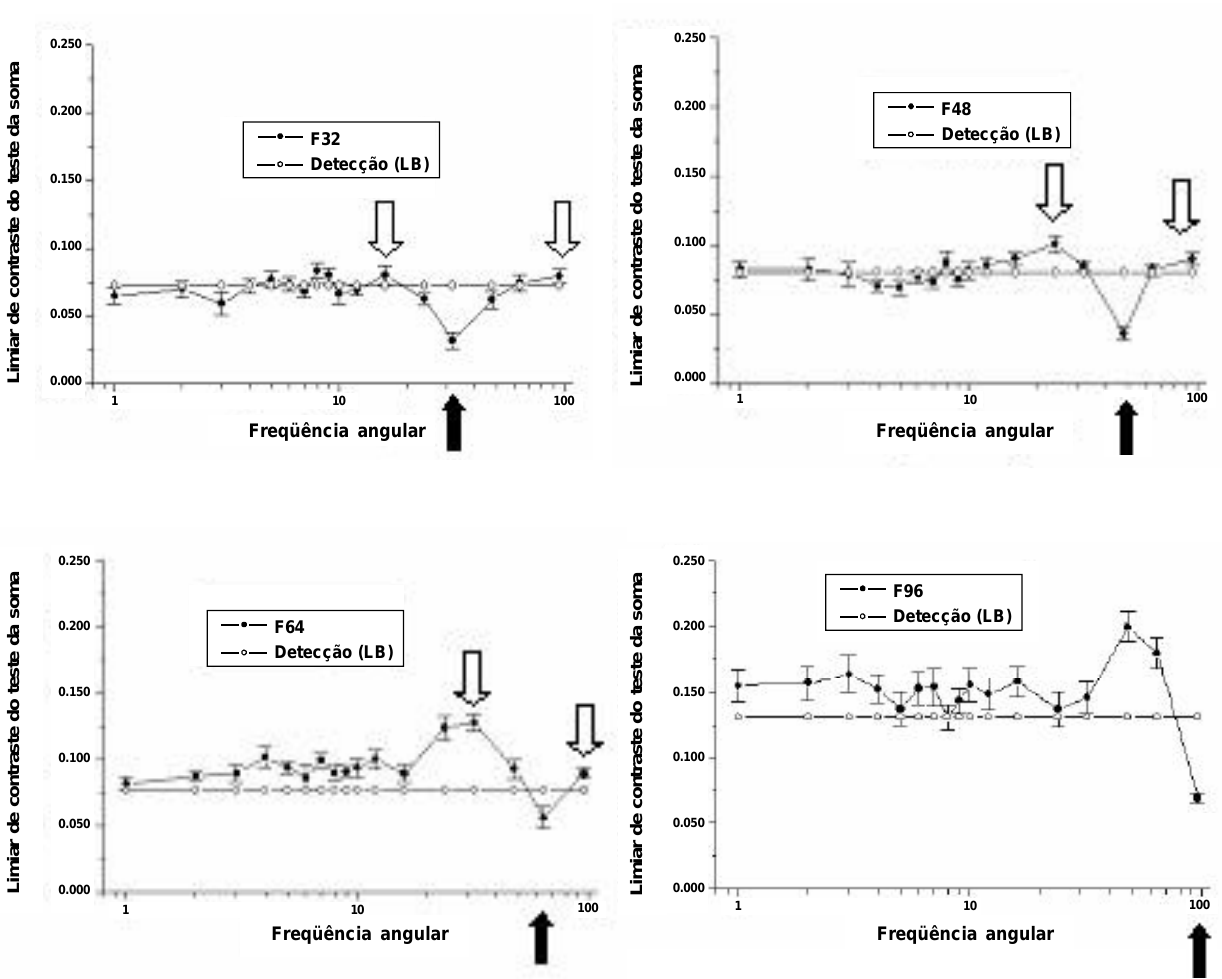
Figura 2 . Curvas de resposta ao contraste da freqüência angular de teste de 32 (acima à esquerda), de 48 (acima à direita), de 64 (abaixo à esquerda) e de 96 ciclos/360 o (abaixo à direita) somada às respectivas freqüências angulares de fundo representadas na abscissa. As setas pretas indicam os limiares de somação e as brancas os de